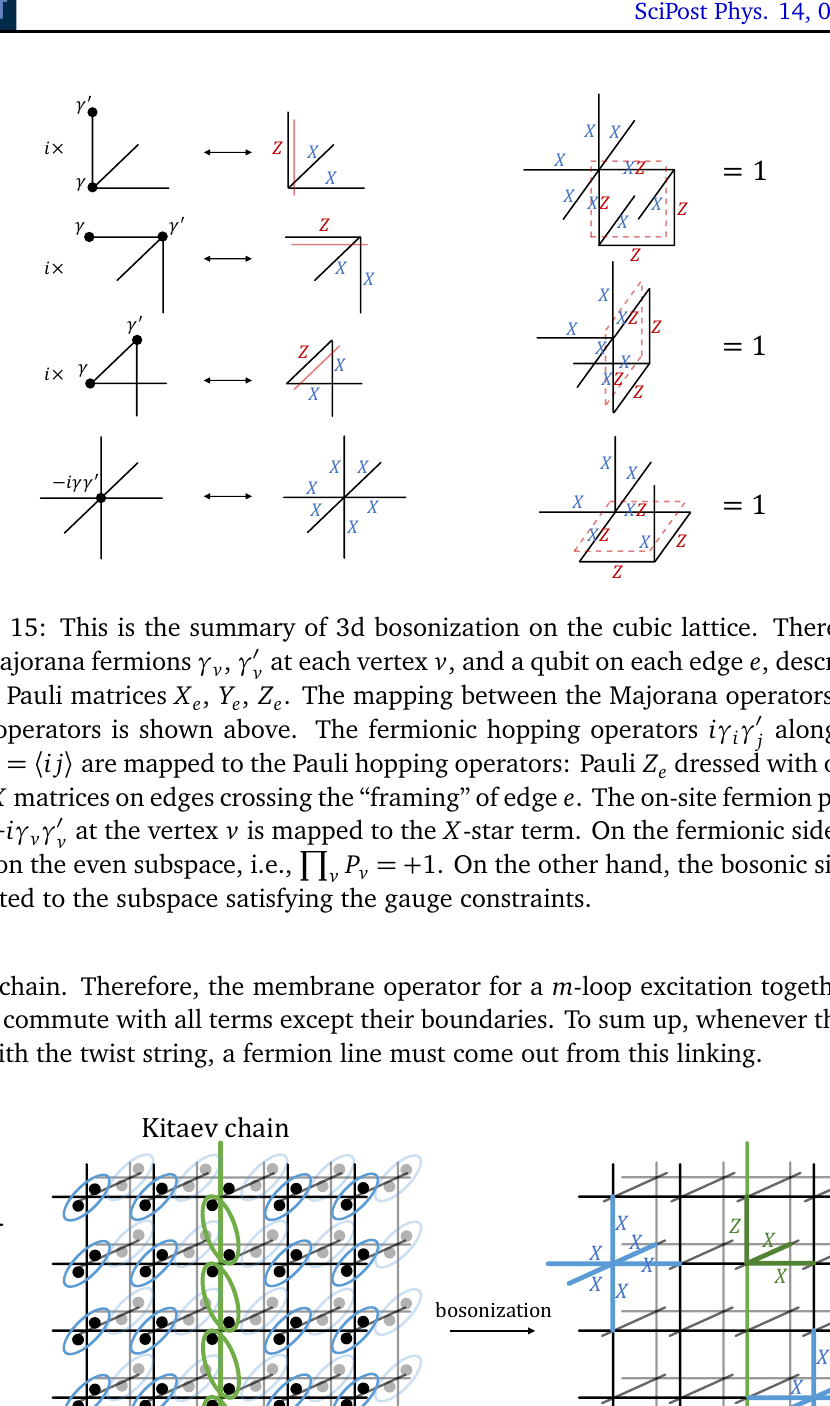
Figure 16: Left: each dot present a Majorana fermion. The Kitaev chain is decorated on the defect (green line), which makes the Majorana fermion paired with the other one on its adjacent vertex; otherwise, Majorana fermions are paired within each vertex. Right: after bosonization, the pairing term on the Kitaev chain becomes the Pauli hopping operator on the twist string, while the pairing term in each face not on the Kitaev chain becomes the X star term. The gauge constraints in Fig. 15 hold at all